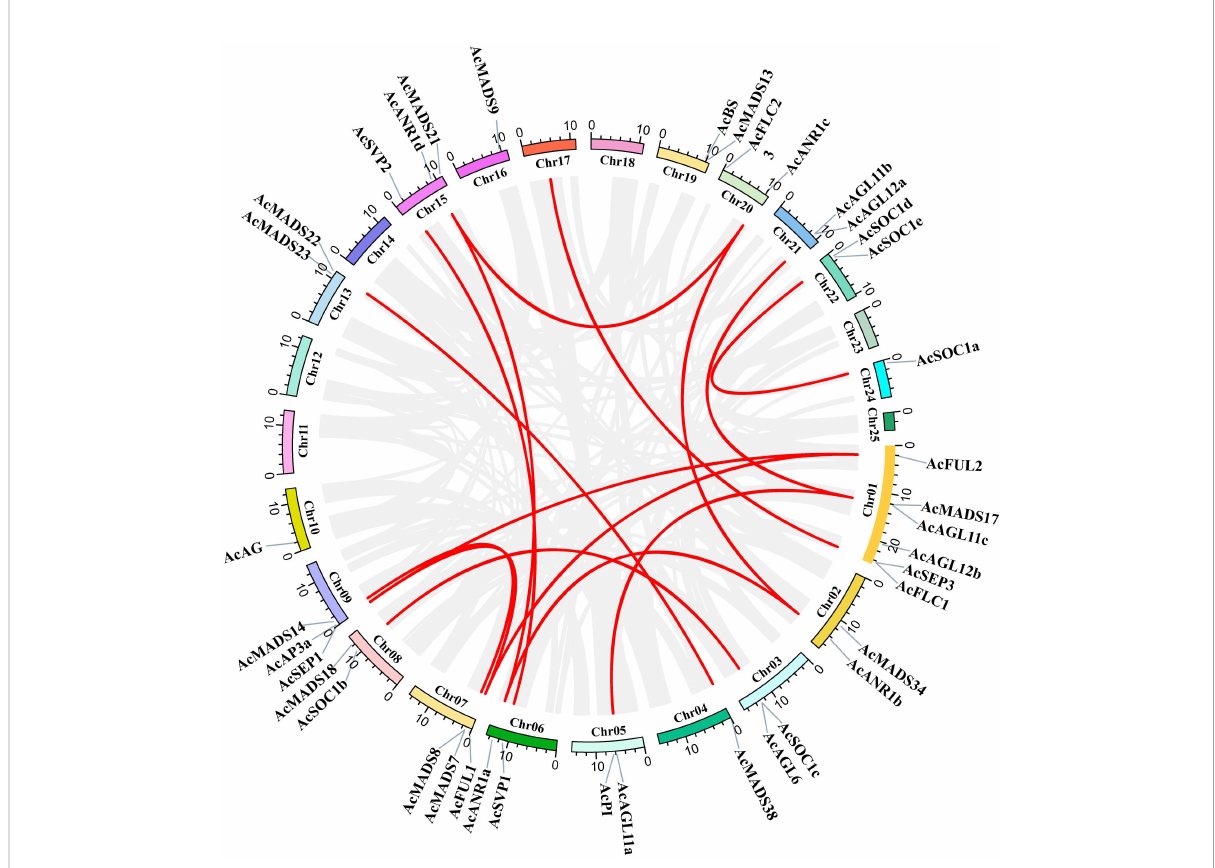
FIGURE 4 Schematic representations for interchromosomal relationships and segmental duplication events of pineapple MADS genes. The gray lines represent all collinear blocks within the pineapple genome, and the red lines denote duplicated MADS gene